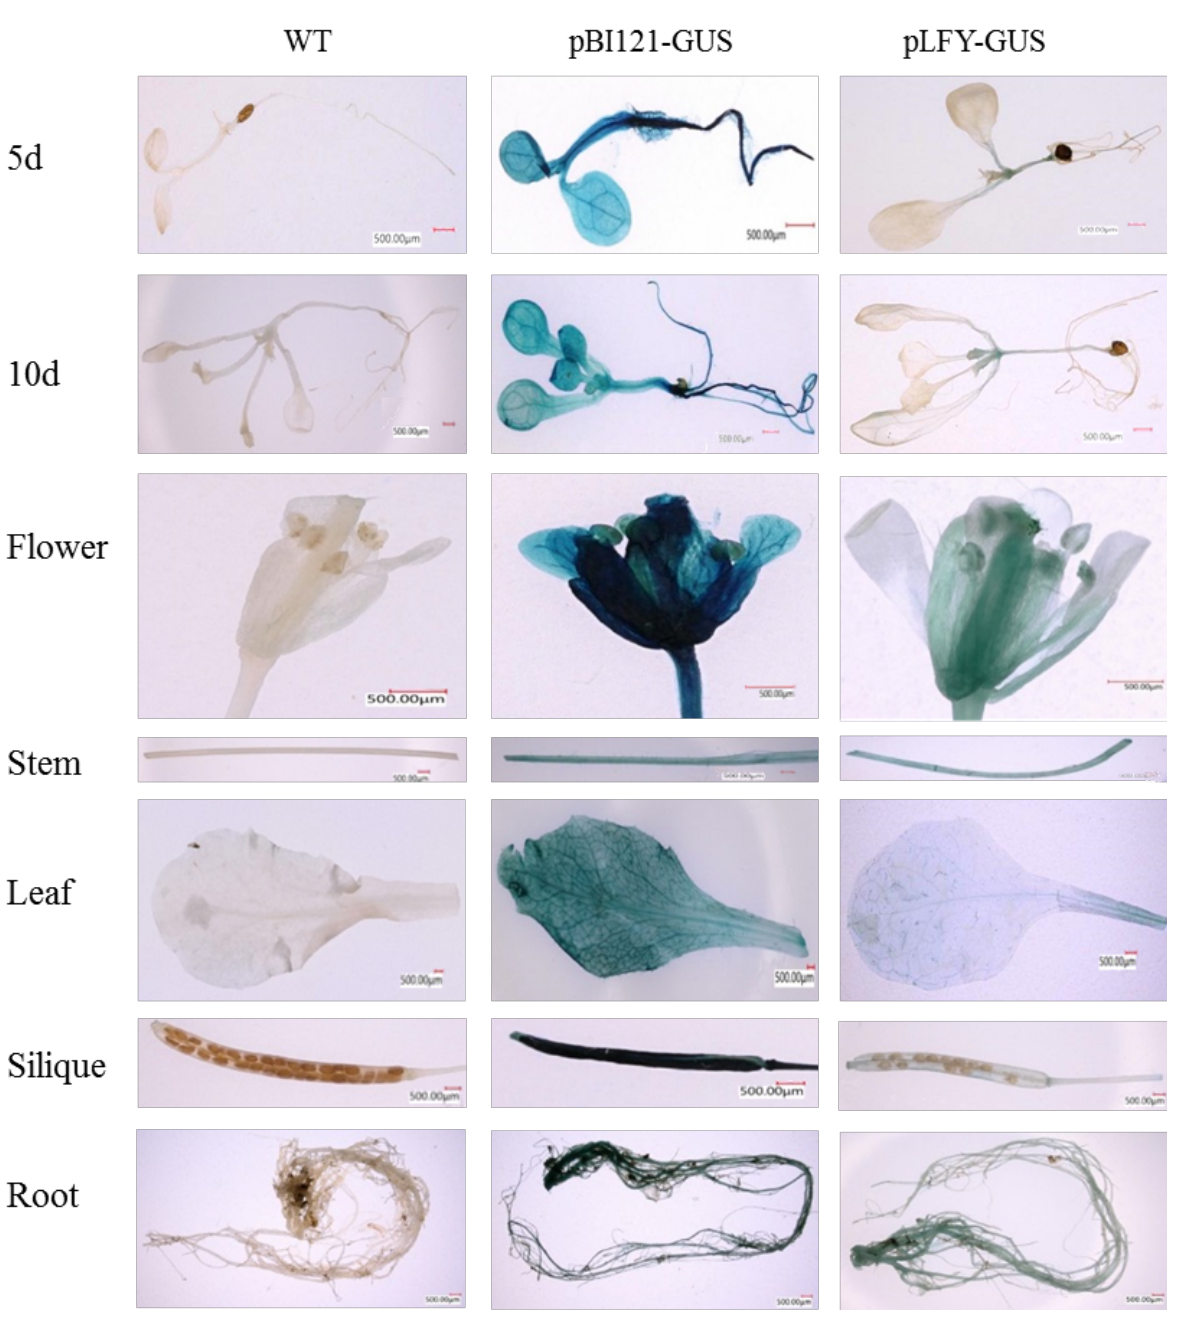
Figure 6. GUS staining in different organs and at different stages in transgenic pLFY-GUS plants, pBI121-GUS vector plants and WT